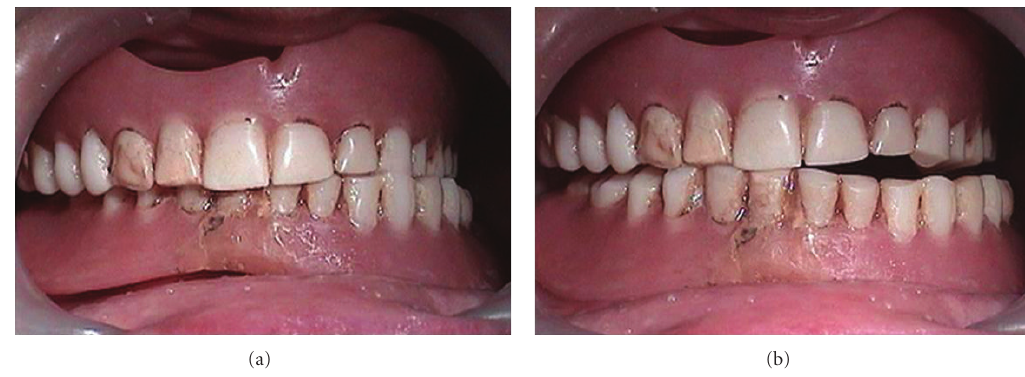
Figure 2: Wear of prosthetic denture teeth leading to di ffi culty in